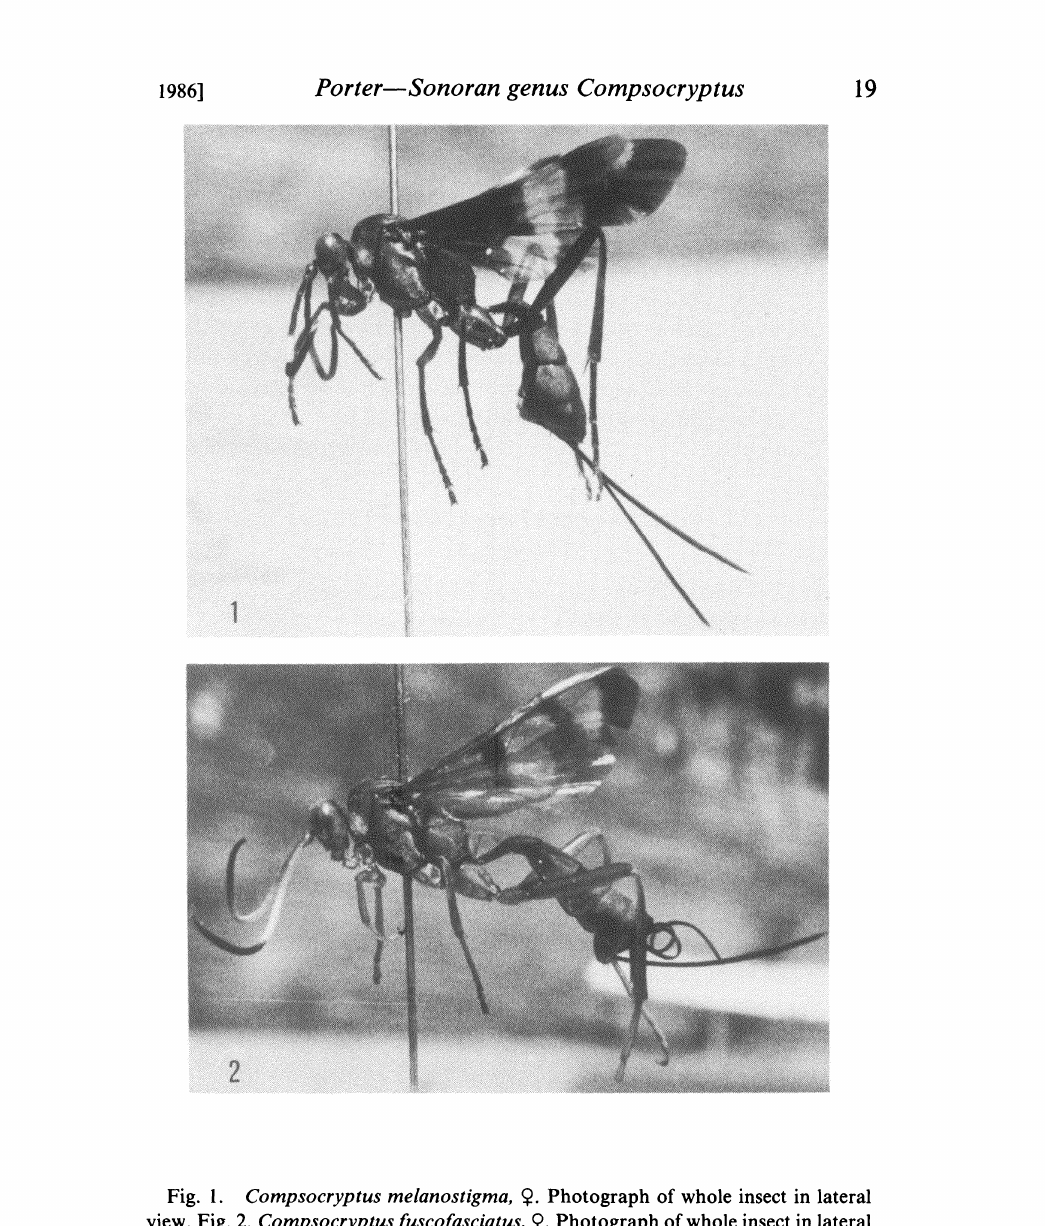
.. . Photograph of whole insect in lateral Photograph ofwhole insect in lateral